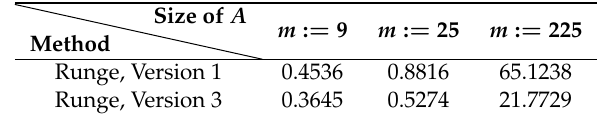
Table 2. Results of a comparison between the runtimes (in seconds) of the Runge method in its Versions 1 and 3.